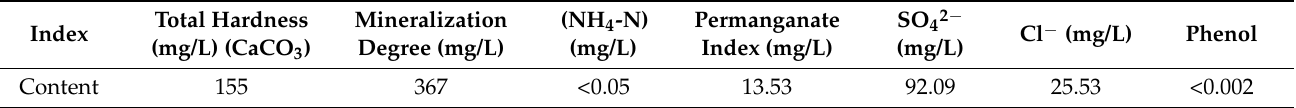
Table 2. Irrigation water